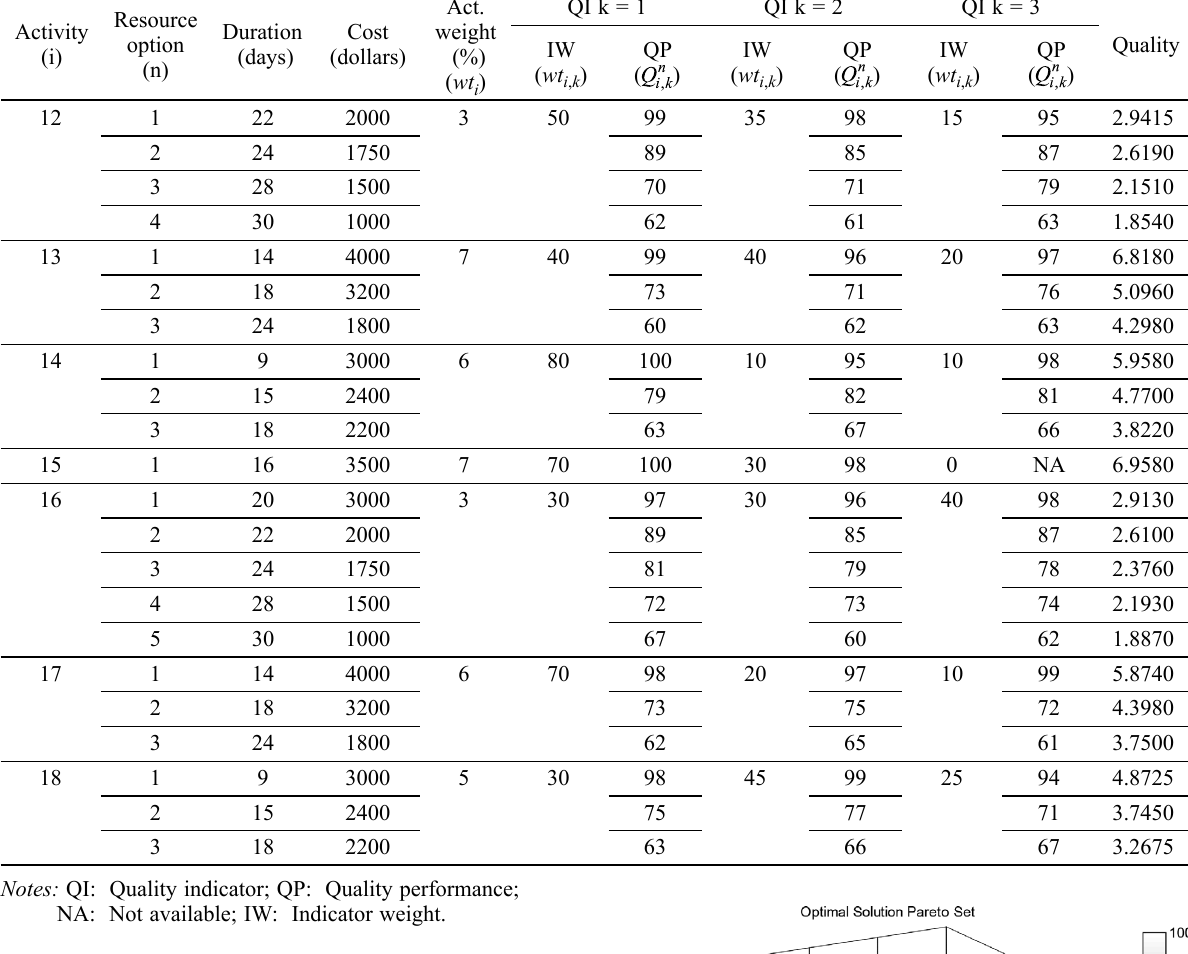
Table 2. CAMODE-TCQT’s parameter setting